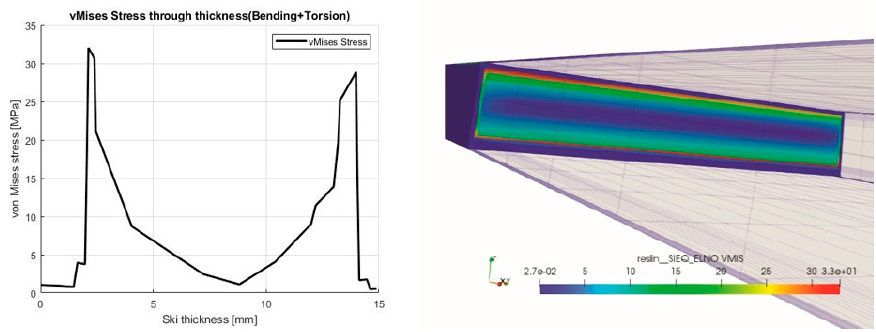
Figure 15. Solid model results—torsion-bending test (normal and Von Mises stresses in the section).